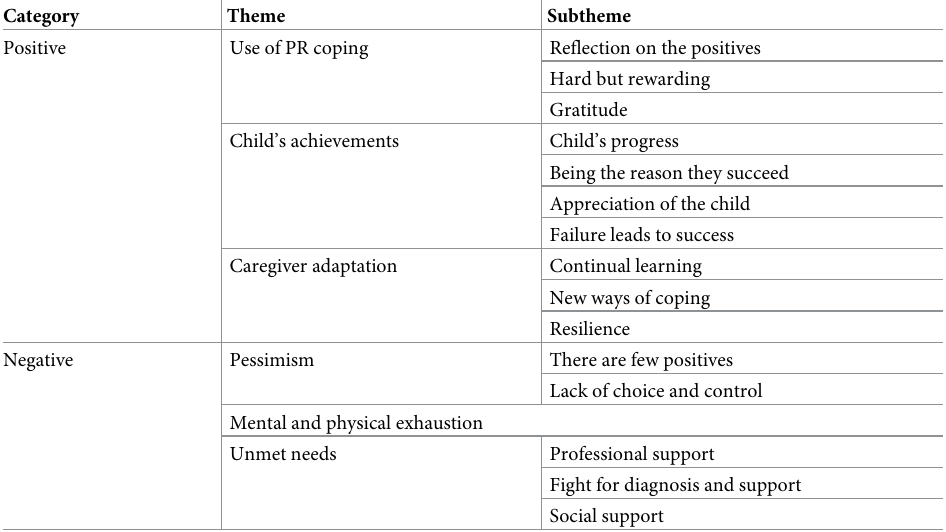
Table 3. Identified categories, themes and subthemes from Thematic Analysis.